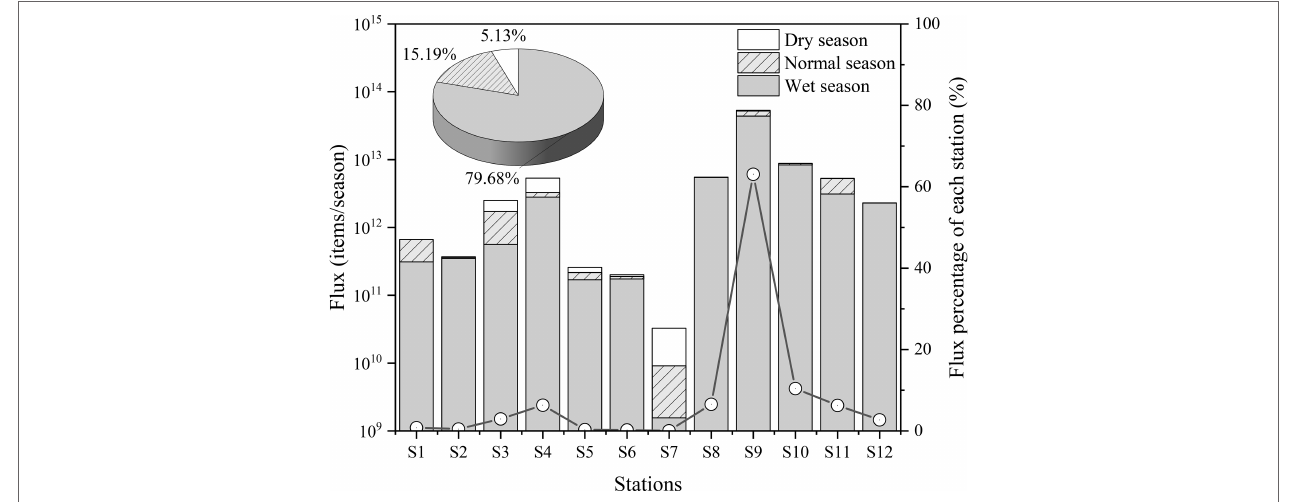
FIGURE 6 | The total amount of MPs from land-based sources in ZJB.